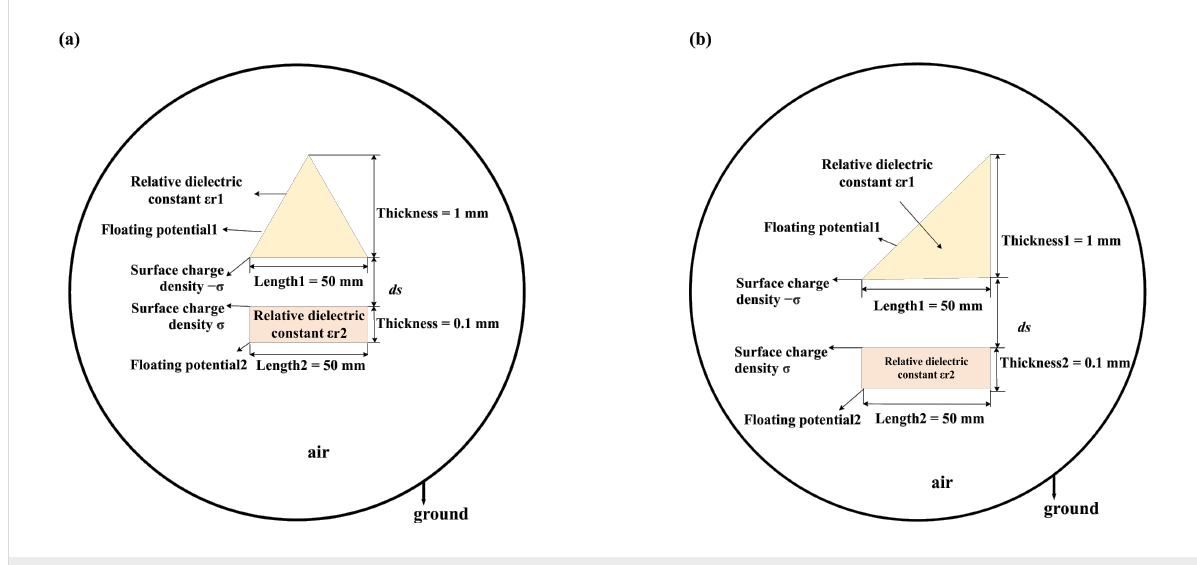
Figure 4: Two-dimensional TENG model with (a) isosceles triangle and (b) right-angled triangle TENG model.